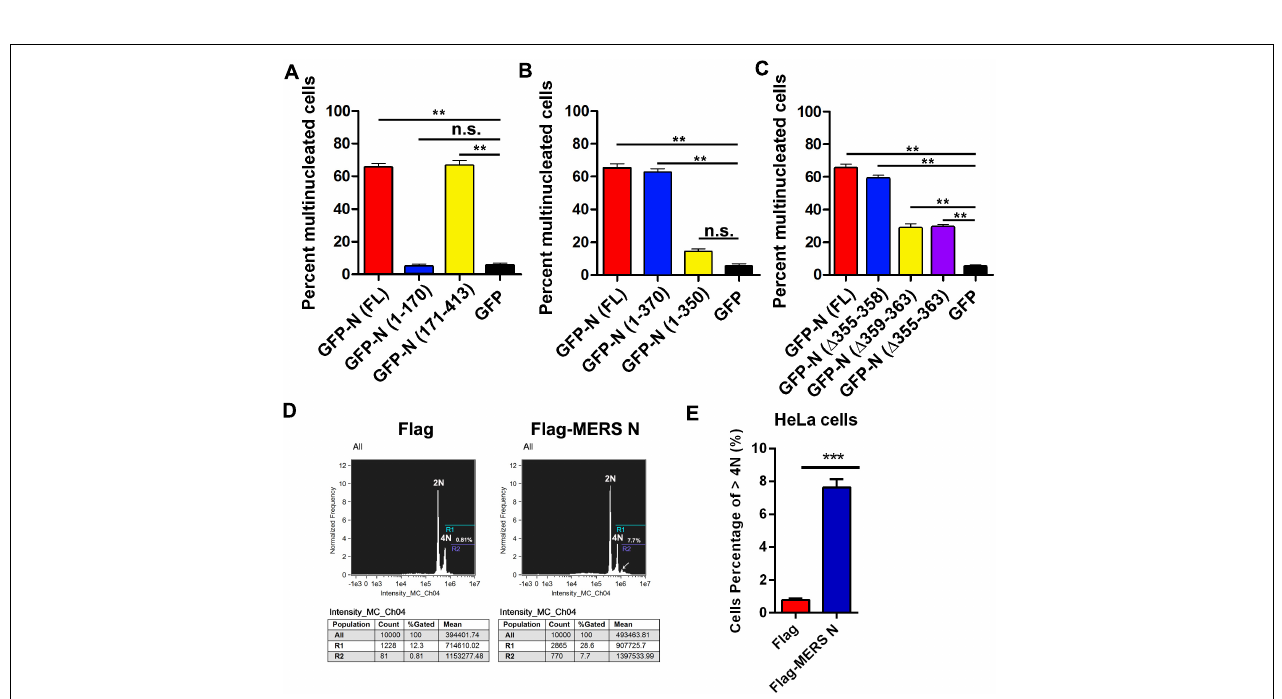
FIGURE 6 | Residues 359–363 of the MERS-CoV N protein is the crucial motif involved in the N-induced multinucleation. (A–C) HeLa cells transfected with plasmids expressing the indicated proteins [GFP-N(FL) or deletion mutants] were fixed and stained for immunofluorescence. To calculate the ratio of multinucleated cells, at least 100 cells were counted for each sample. The data are presented as the mean ± SD of three independent experiments. ** P < 0.01 vs. GFP by unpaired two-tailed Student’s t -test. (D) HeLa cells were transfected with Flag-vector or Flag-MERS N for 60 h. Then, the cytokinesis of HeLa cells were monitored by flow cytometry analysis after DNA staining with propidium iodide. (E) Quantitative flow cytometry data (cells percentage of > 4N) are plotted in the graph. *** P < 0.001 vs. Flag by unpaired two-tailed Student’s t -test.